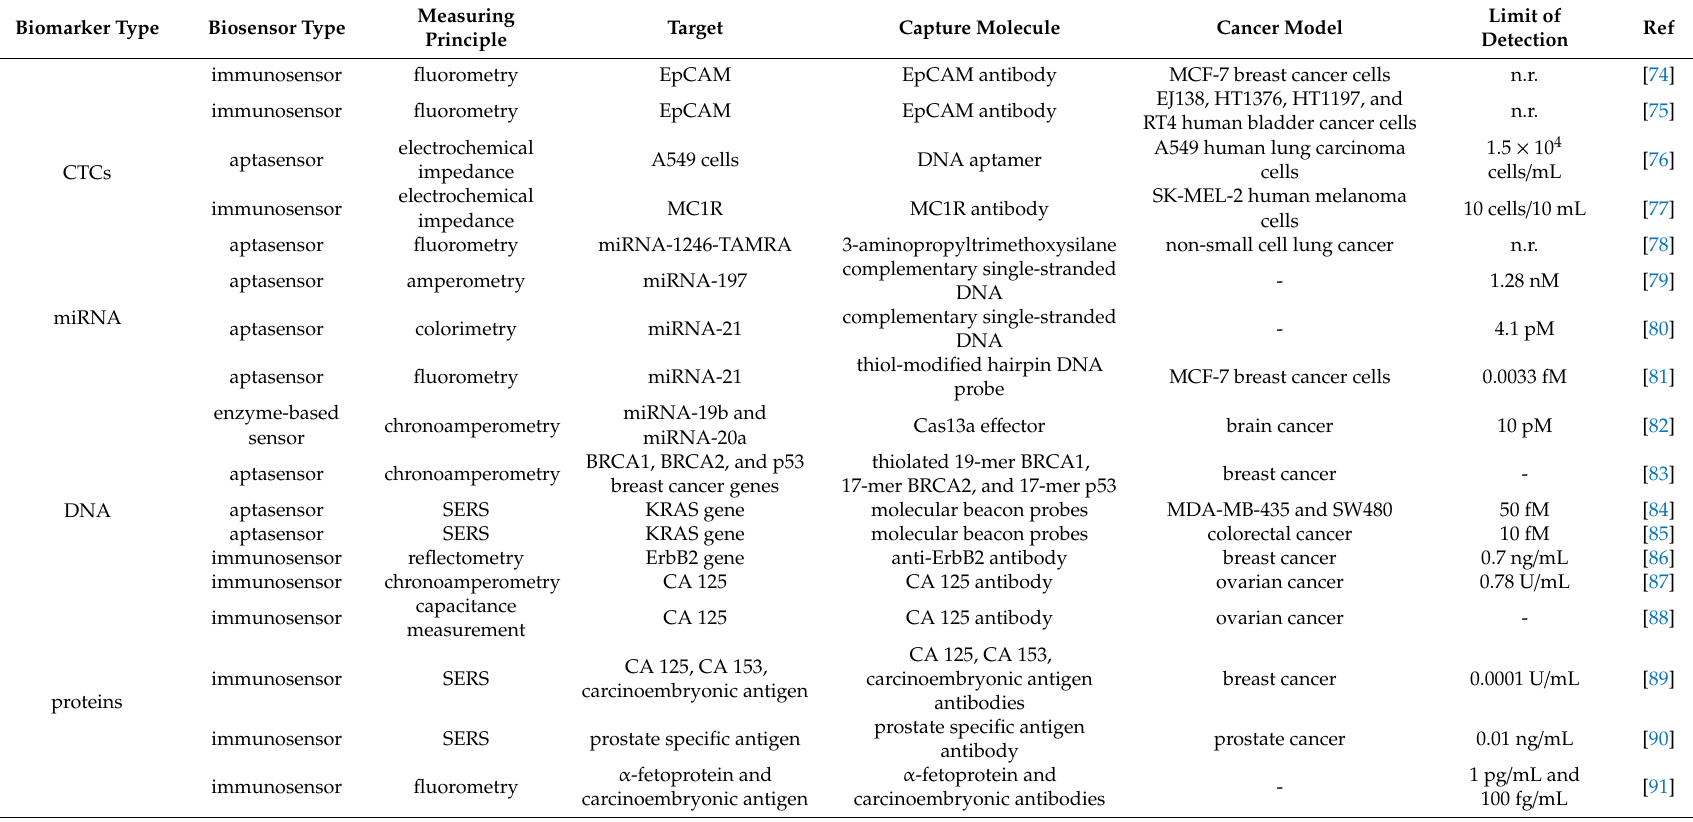
Table 1. A summary of the identified papers investigating the use of microfluidic biosensors for cancer